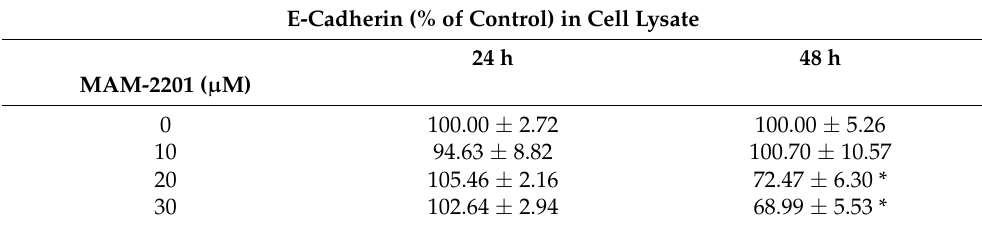
Table 1. E-cadherin evaluation in D384 spheroids after 24 and 48 h of exposure to MAM-2201. E-Cadherin (% of Control) in Cell Lysate